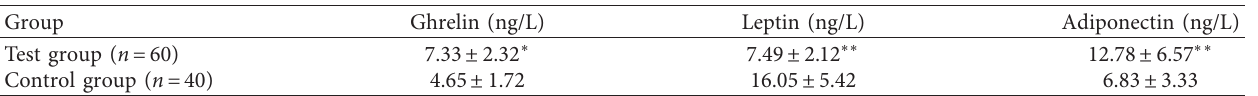
Table 4: The serum levels of ghrelin, leptin, and adiponectin between the test and control groups. Group